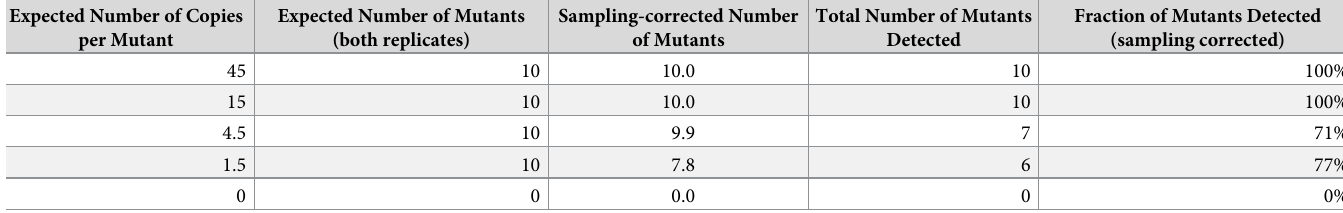
Table 1. Molecular sensitivity